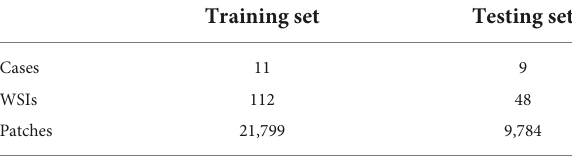
TABLE 1 The overview of the dataset for network training.